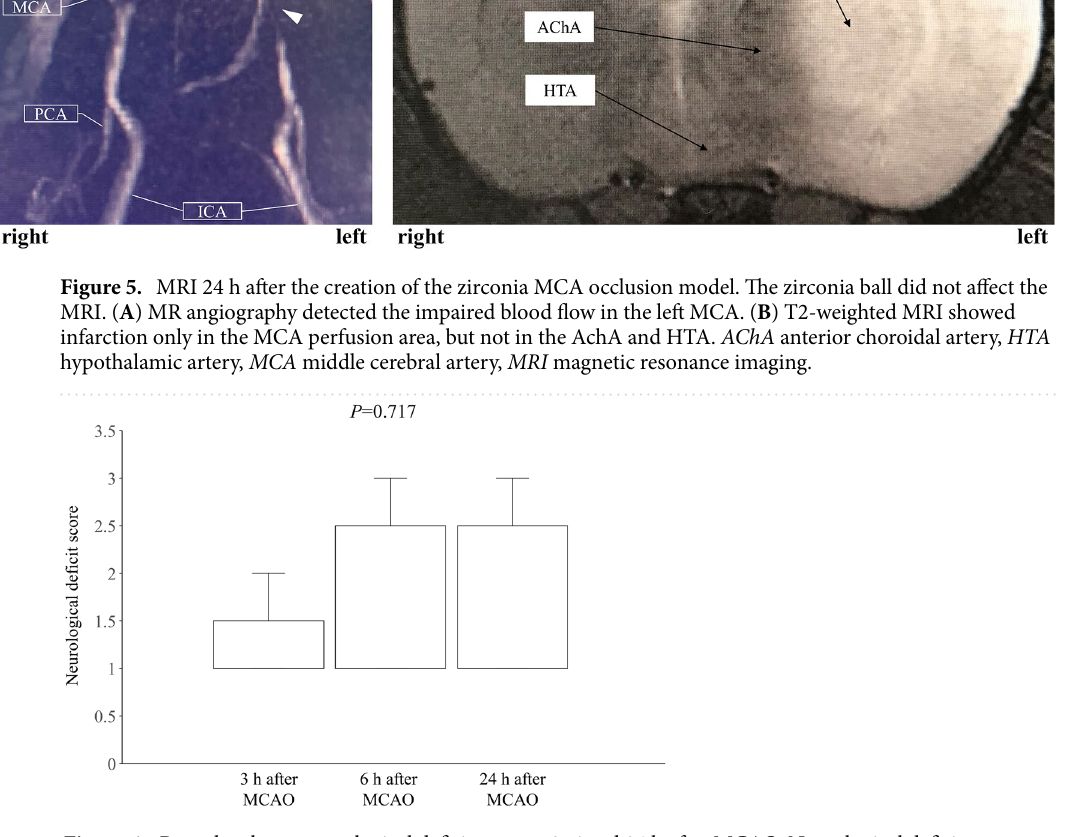
Figure 6. Box-plot shows neurological deficit score at 3, 6 and 24 h after MCAO. Neurological deficit scores were not statistically different at any time point (P = 0.717; Friedman’s test). MCAO occlusion of the middle cerebral